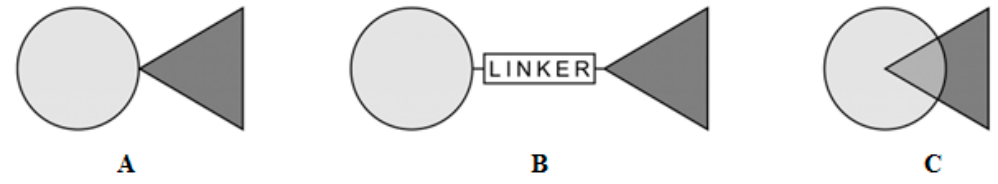
Figure 1. General integration modes of active dual structures. ( A ) Direct no-linker mode (fused hybrids); ( B ) Intermediate linker mode; ( C ) Overlap mode (merged hybrids).